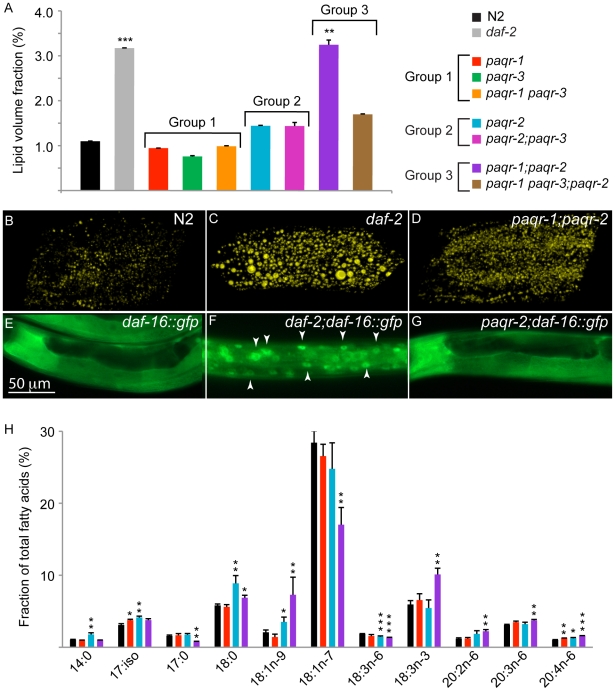
CARS microscopy and gas chromatography analysis of lipids.(A) Shows the fraction of the measured worm volumes occupied by lipid droplets (LVF). (B–D) show pictures of the worm with the LVF closest to the average for N2 (B), daf-2 (C) and paqr-1;paqr-2 (D). (E–G) Localization of DAF-16::GFP in N2, daf-2 dauer larvae and paqr-2 worms, respectively. Note the nuclear localization of DAF-16::GFP in the dauer larva (arrowheads in F) but not in control or paqr-2 mutants. (H) Relative abundance of fatty acids that differed significantly between wild type and paqr-1, paqr-2 or paqr-1;paqr-2 mutants. * p<0.05, ** p<0.01, *** p<0.001 using Student's t-test in (A; test done on arc sin transformed data) and (H); error bars show the sem.